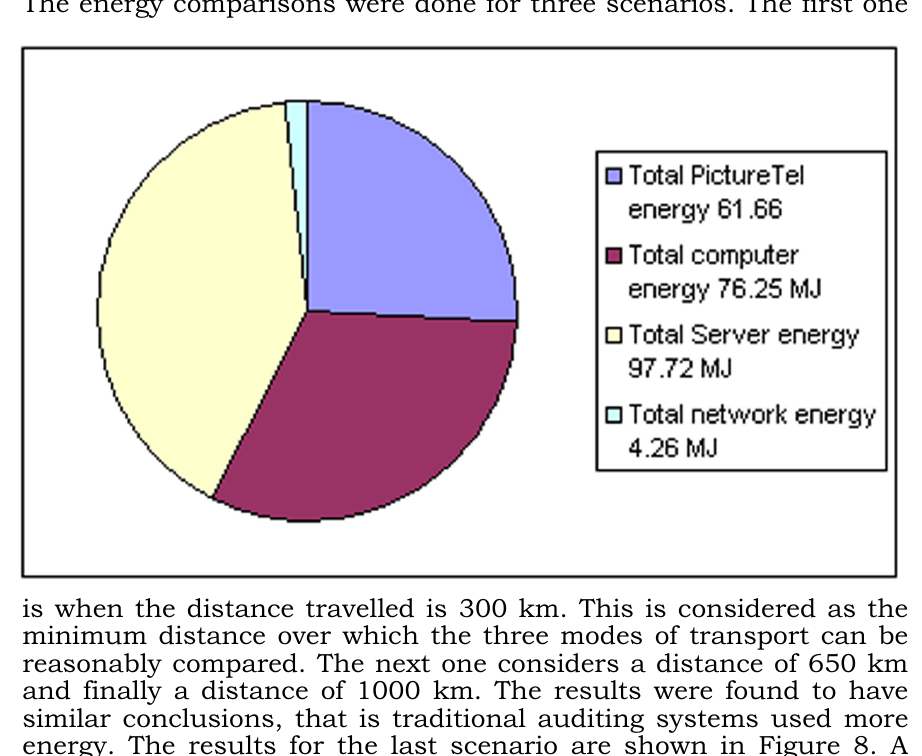
Figure 7: Energy use for the electronic auditing